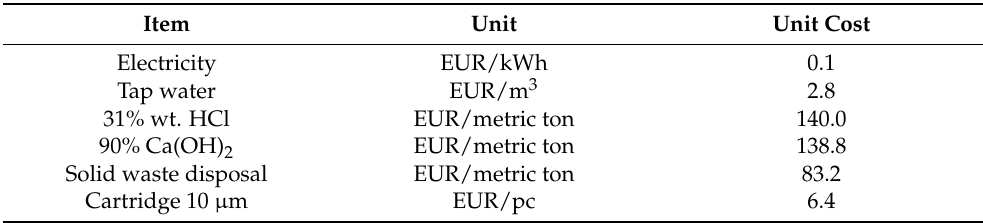
Table 6. Unit costs of the used media, including waste disposal. The prices of the listed items reflect the situation in the Czech